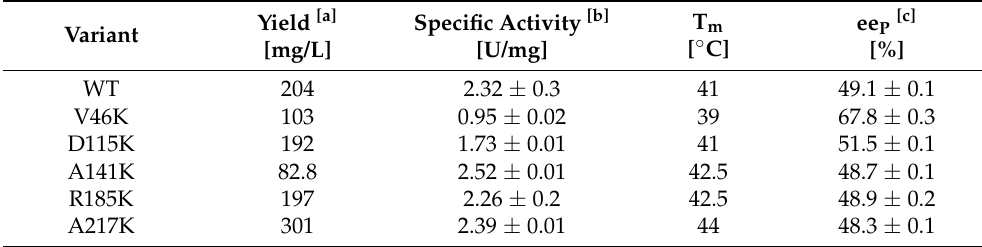
Table 1. Specific activities and product enantiomeric excess (ee P ) in the conversion of cyclohexene oxide with azide as nucleophile, as well as apparent melting temperatures (T m ) of HheG wild type and respective variants applied as soluble enzymes. Specific activity and product enantiomeric excess (ee P ) were determined based on duplicate measurements, apparent melting temperatures (T m ) were obtained from triplicate measurements. Yield Variant